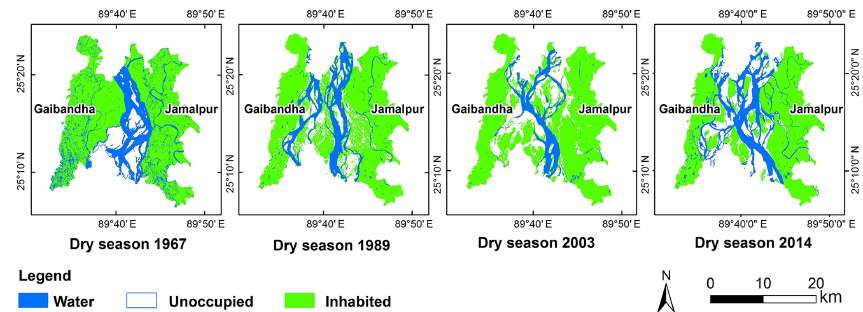
Figure 7. Time series dry season satellite images of the case study